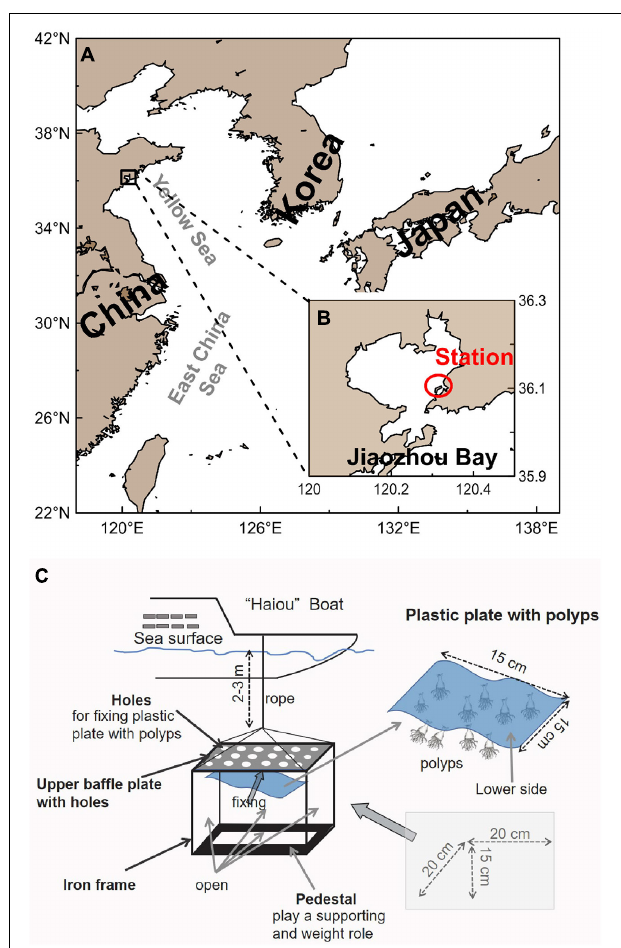
FIGURE 1 | Study area and schematic diagram of Aurelia coerulea polyps in situ feeding experiment. (A) Map of Jiaozhou Bay. (B) Station in Jiaozhou Bay where the plastic plates carrying polyps were deployed. (C) A roof (20 cm × 20 cm × 15 cm) with four open sides was used to support the plastic plate carrying the polyps; the upper side was a baffle plate to simulate the bottom of “Haiou” boat, and the holes were used to fix plastic plate and tie a rope; the lower side was a pedestal that played a supporting and weight role. Polyps were attached to the lower side of the plastic plate (15 cm × 15